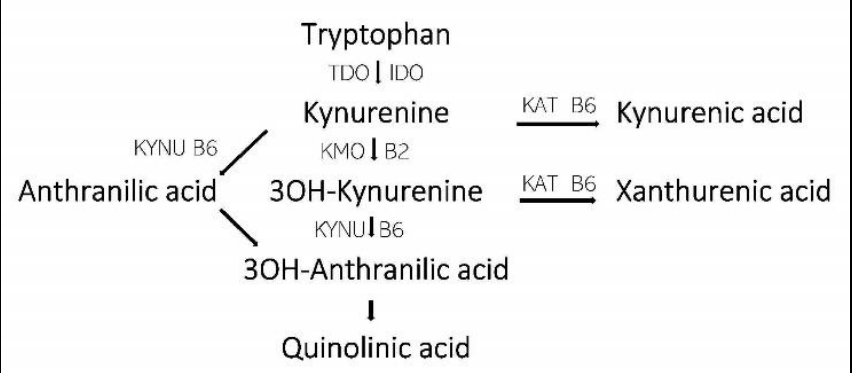
Figure 1. Schematic outline of the Kynurenine pathway limited to the steps presented in this paper. TDO: Tryptophan 2,3-dioxygenase. IDO: indoleamine 2,3 dioxygenase. KAT: Kynurenine aminotransferase. KUNU: Kynureninase. KMO: kynurenine 3-monooxygenase. B6: Vitamin B6.